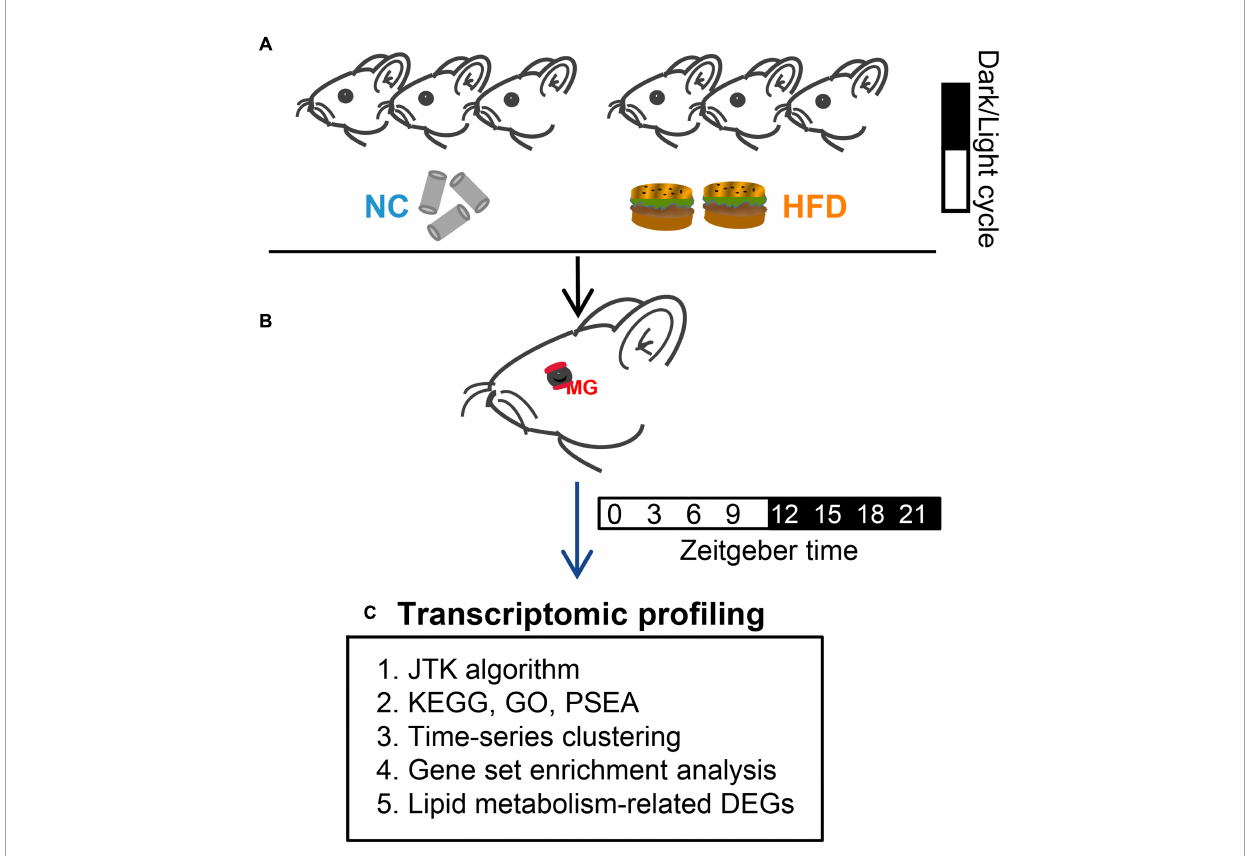
FIGURE1 Experimental design. (A) After adaption, all mice were divided randomly into two groups. Mice in the NC- and HFD-fed groups were provided with standard normal chow and a high-fat diet for 4 weeks, respectively. (B) MGs were obtained from euthanized mice at 3-h intervals (for transcriptomic profiling analysis) or 6-h intervals (for ORO staining) over a 24-h circadian cycle. (C) High-throughput sequencing (RNA-Seq) was performed after MG collection. Circadian gene identification and circadian transcriptomic analysis were performed using the Jonckheere–Terpstra–Kendall (JTK) cycling algorithm. The biological processes and molecular function of genes were annotated by the Kyoto Encyclopedia of Genes and Genomes (KEGG), Gene Ontology (GO), phase set enhanced analysis (PSEA), time-series clustering analysis, and gene set enriched analysis